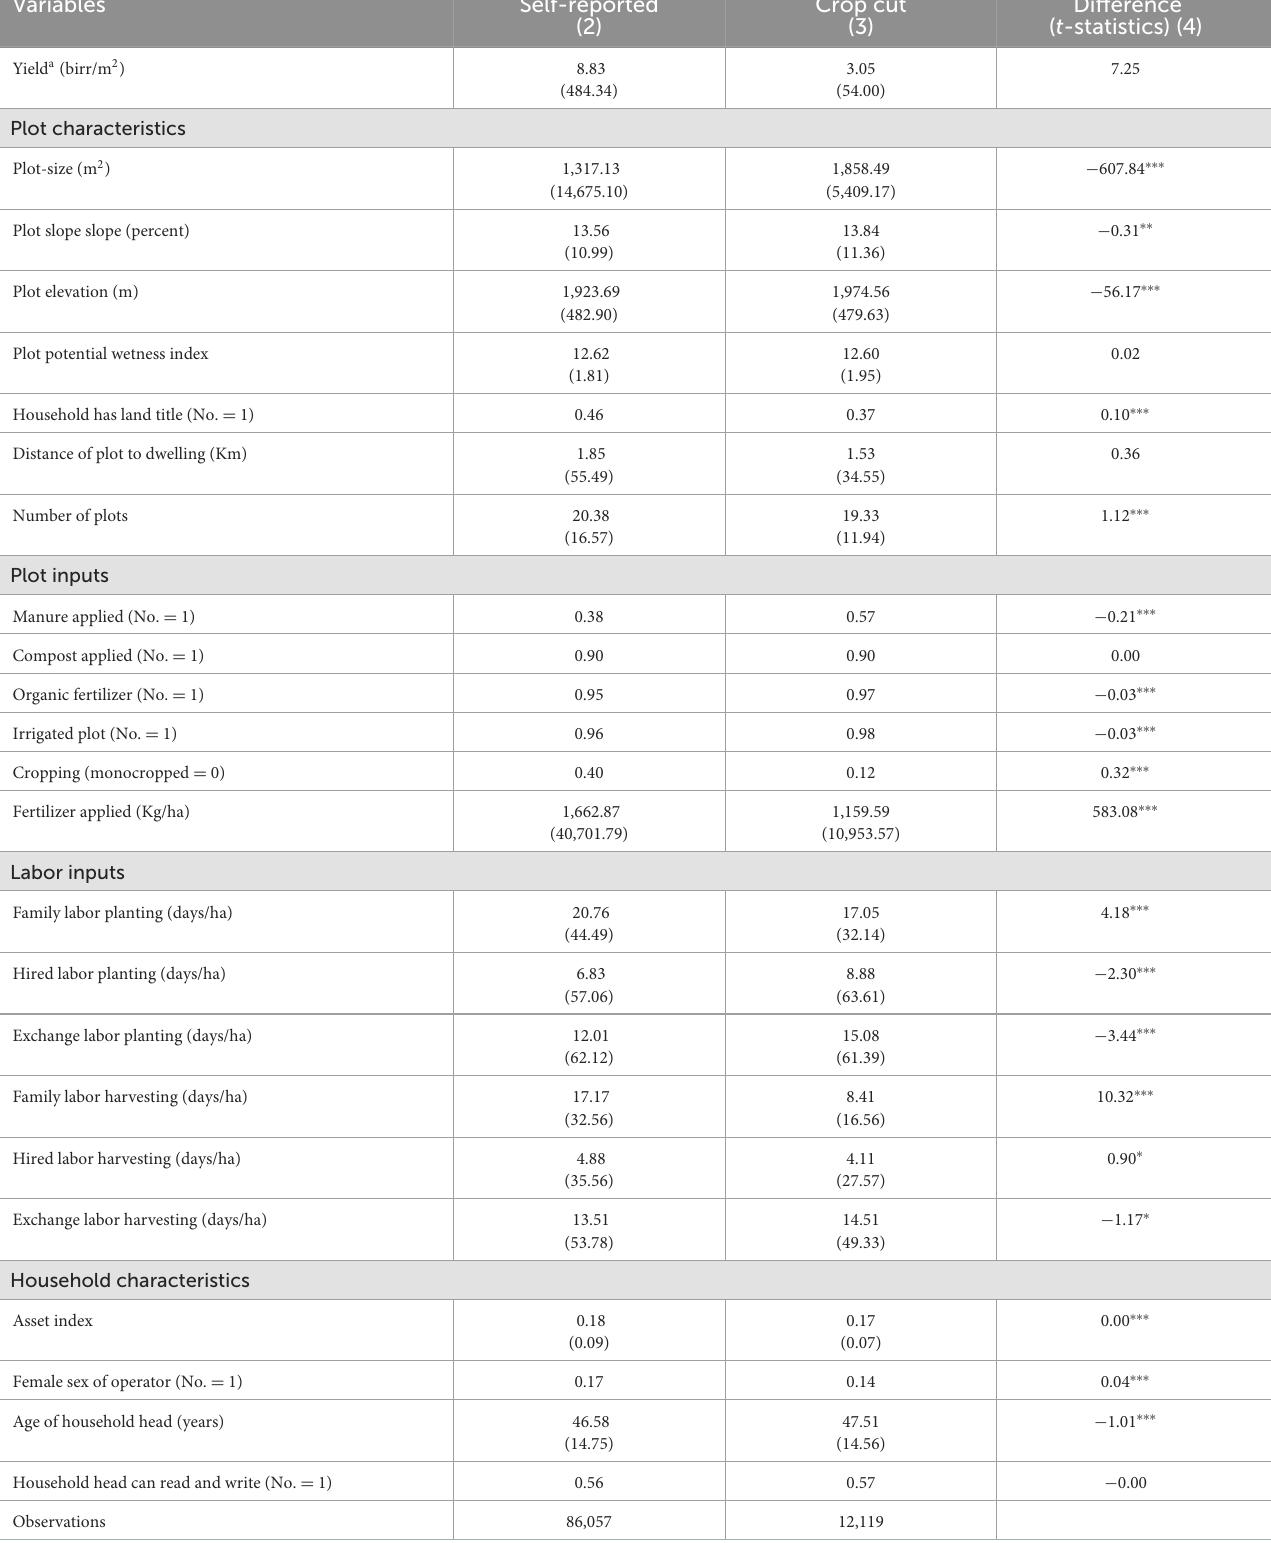
TABLE 1 Summary statistics, self-reported vs. crop cuts, all waves.